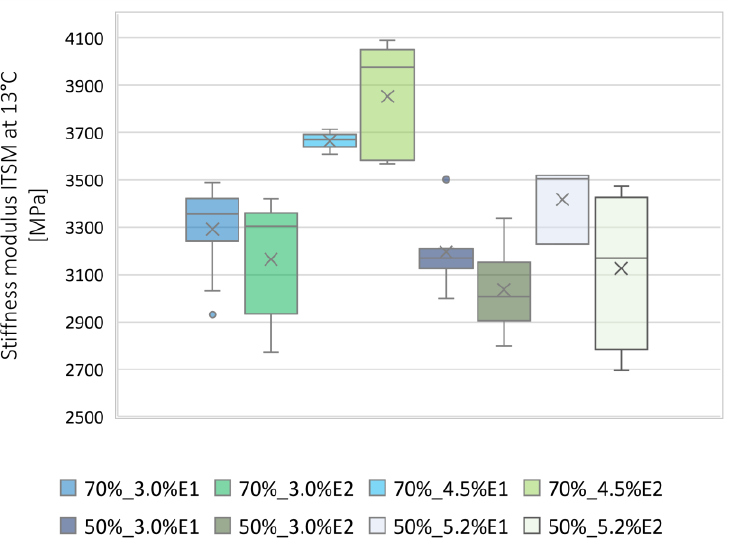
Figure 6. Box plot of ITSM values at 13 °C.